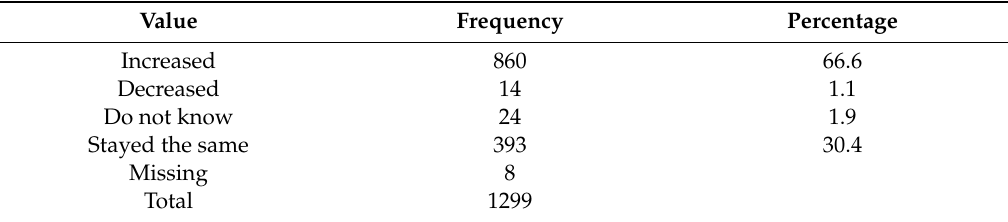
Table 3. The change of physical activity since the beginning of trail use, reported by trail users.